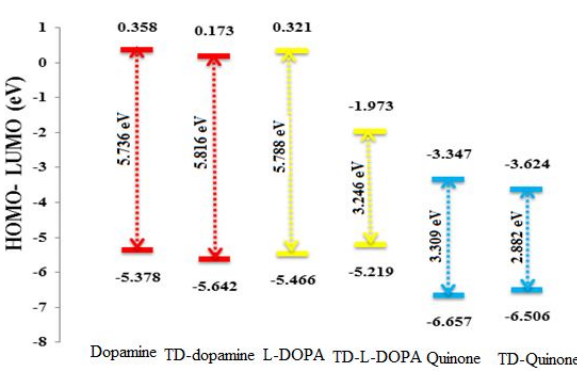
Figure 3 represents the infrared spectrum diagram of